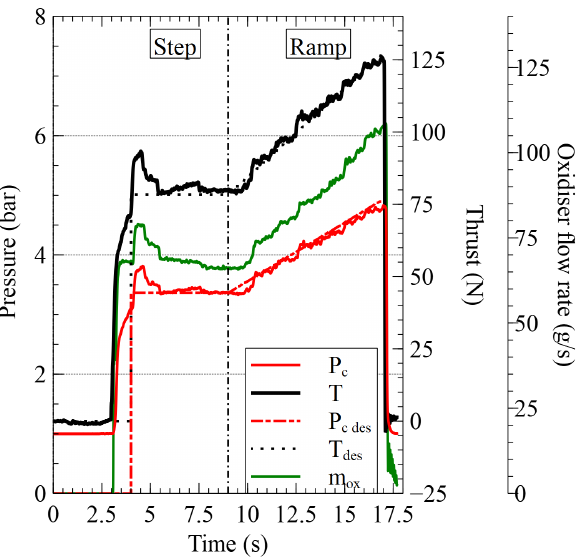
Figure 17. Step and ramp input response.